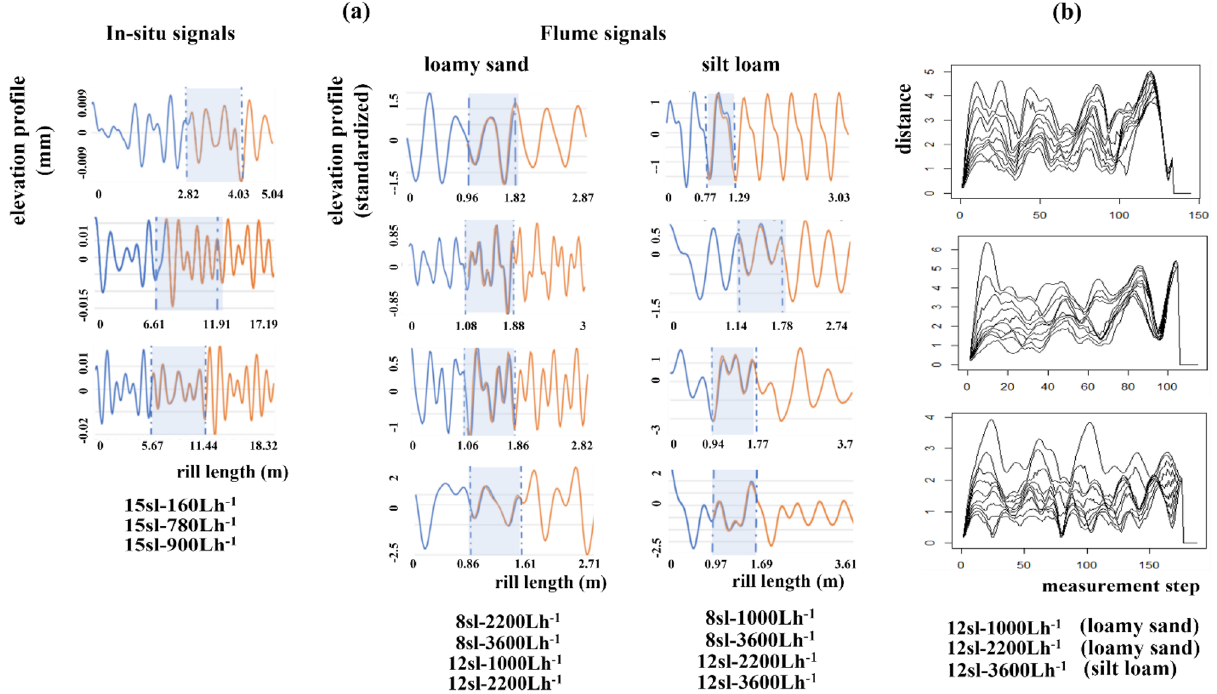
Figure 6. Modeling shadow attractors with Echo State Neural Network (ESNN) machine learning. ( a ) Each performance plot shows the rill signal in the training set (blue curve to left of shaded area), the rill signal in the testing set (blue curve within the shaded area), ESNN in-sample predictions (orange curve within shaded area), and ESNN out-of-sample forecasts (orange curve to right of shaded area). The shaded area represents the testing interval in which ESNN predictions (orange curve) are plotted with the rill signal in the testing set (blue curve). In each plot, ESNN predicts with almost-perfect skill ( NSEs > 0.95) as evidenced by orange curves overlapping blue curves in the shaded area. Forecasts largely preserved oscillatory behavior observed in corresponding rill profile signals. ( b ) We used ESNN forecasts to extend the lengths of three non-stationary flume rill signals and re-tested for stationarity with space–time separation plots. The plots show that the extended rill signals are now